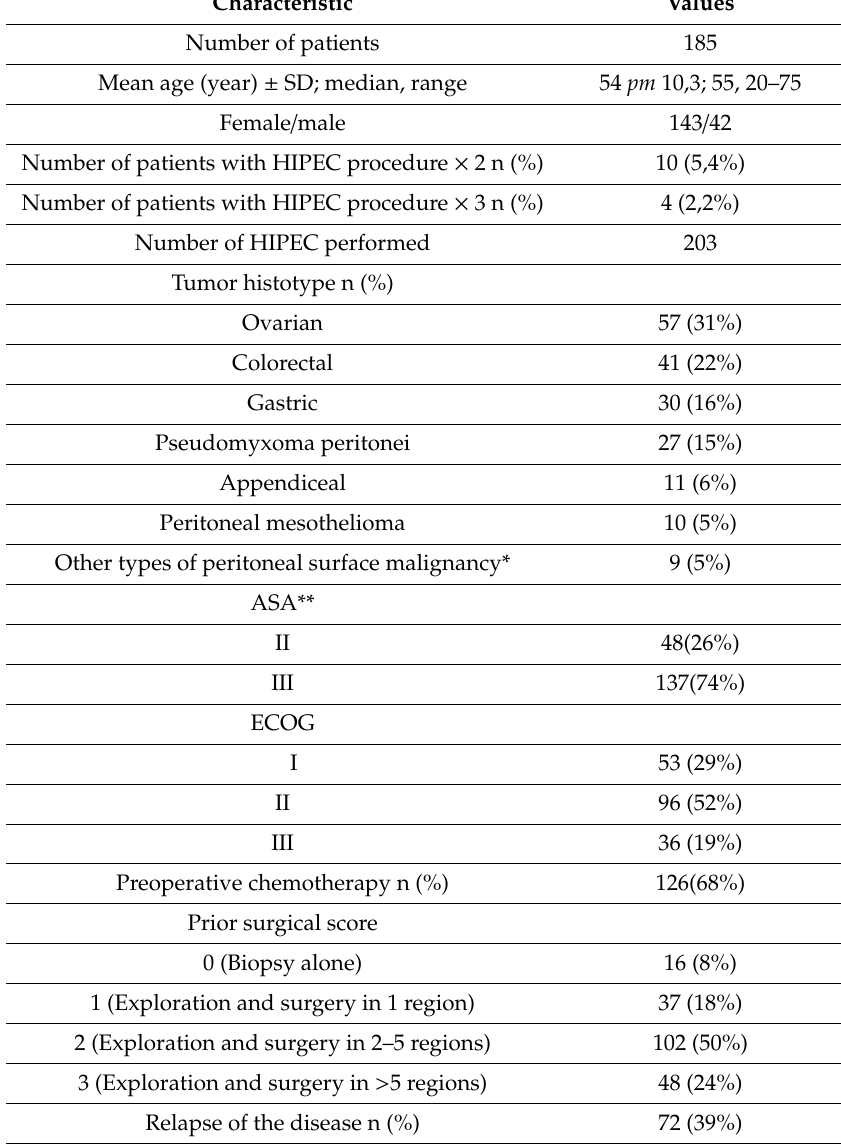
Table 1. Demographic data and clinical features of patients treated with CRS + HIPEC. Characteristic Values Number of